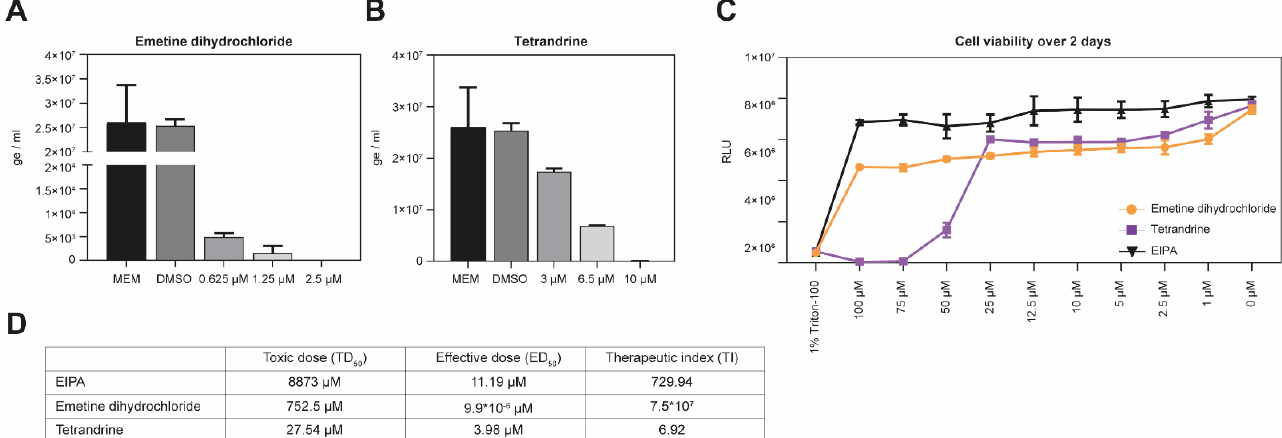
Figure 7. Validation with authentic pathogenic viruses. ( A , B ) Vero E6 cells were pre-incubated with emetine dihydrochloride (panel A), or tetrandrine (panel B) at the indicated concentrations for 45 min at 37 °C, followed by HTNV infection for 1 h at 37 °C. Cells were subsequently washed once with medium and incubated with medium containing appropriate drug concentrations for 48 h. Infection levels were assessed by RT-qPCR. Data are means + SD ( n = 3) of genome per ml. ( C ) Cell viability over two days. Monolayers of Vero E6 cells were treated with the indicated concentration of emetine dihydrochloride or tetrandrine under the assay conditions ( A , B ). After 48 h, intracellular ATP levels were measured using CellTiter-Glo ® assay. Data are means ± SD ( n = 3) of relative light units (RLU). ( D ) Calculation of the therapeutic index (TI). The therapeutic index is defined as toxic dose (TD 50 )/effective dose (ED 50 ).